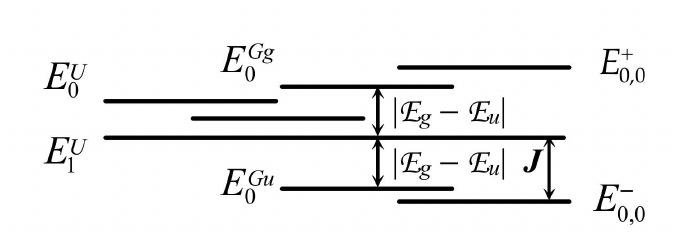
Figure 5. Energy level scheme for the AXB centrosymmetric system (with, here, A = B for the sake of simplicity) when Coulomb interactions are negligible (molecular orbital model). J is given by Equations (39) and